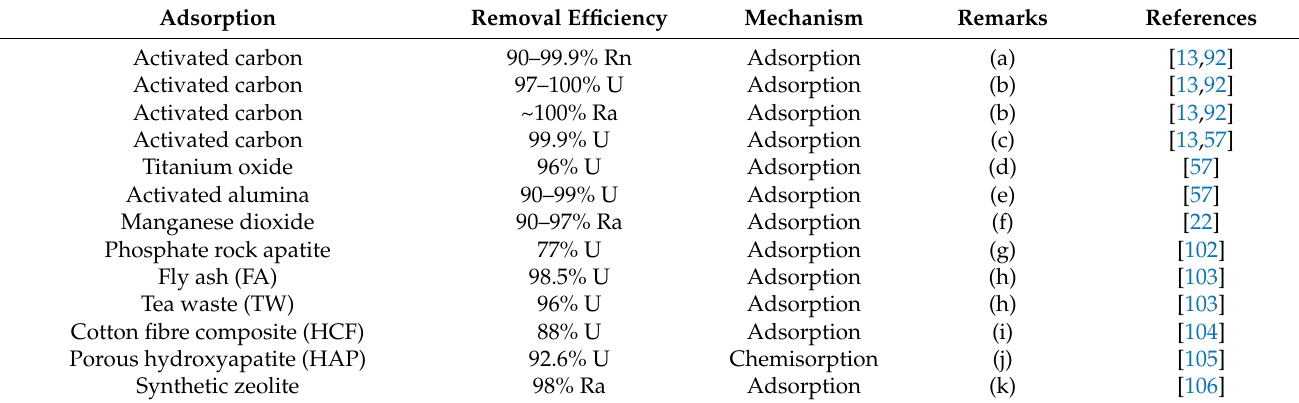
Table 5. Summary of the adsorption performance for uranium, radium, and radon